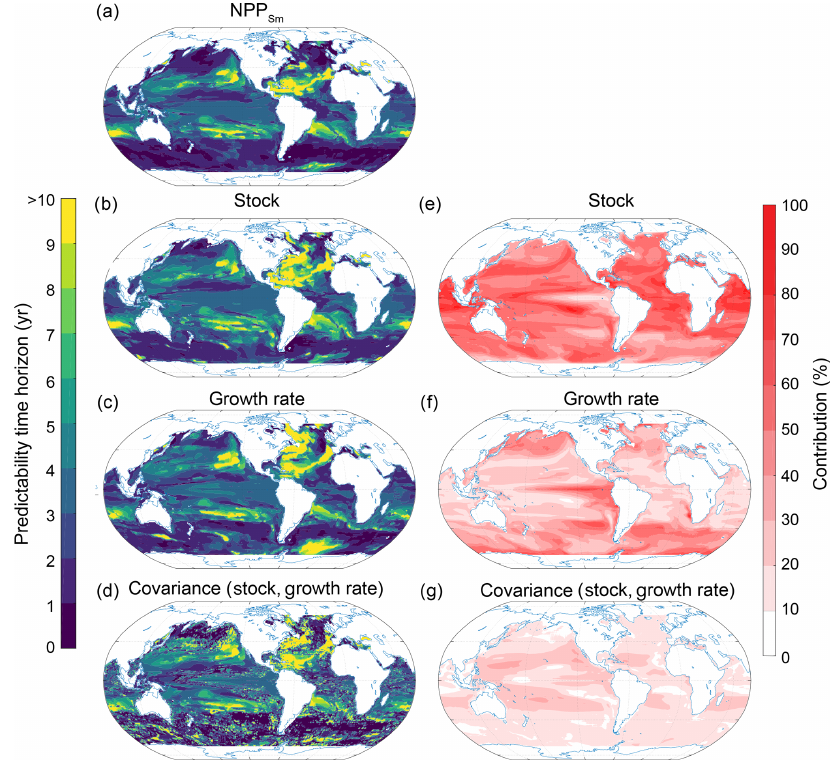
Figure 12. Spatial pattern of the (a–d) predictability horizons and (e–g) contribution of different terms to the predictability of small- phytoplankton production (NPP Sm ) integrated over the top 100m. (a–d) Predictability time horizon for (a) NPP Sm , (b) small-phytoplankton stock, (c) growth rate of small phytoplankton, and (d) the covariance between the stock and the growth rate of small phytoplankton. (e– g) Percentage contributions of (e) stock, (f) growth rate, and (g) covariance of stock and growth rate relative to the sum of all terms. Red shading in panels (e) – (g) represents positive absolute values of the variance and covariance terms. The percentage contributions are shown as averages over the entire 10 years of the simulations. The percentage contributions do not change substantially over the 10 years (always within ± 5% of the 10-year